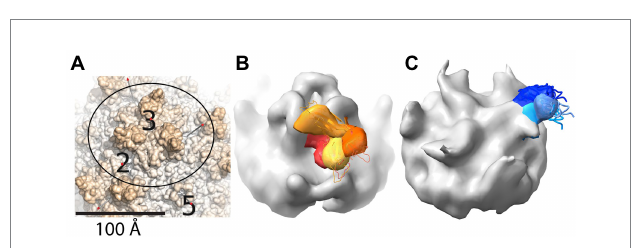
FIGURE 3 Cryo-ET reveals variable locations for neighboring PKD domains that are not strongly bound to AAV. (A) The region shown in panels (B,C) is outlined on part of the surface of the AAV2 crystal structure (PDB ID 1LP3) (Xie et al., 2002). Spikes are seen surrounding a 3-fold axis, with neighboring 2- and 5-fold axes shown for reference. (B) Cryo-ET subtomograms for an AAV2-PKD12 complex have been averaged within four classes that are superimposed with different colors (yellow through red) for the PKD1 domain that is in variable orientation. Regions in common between the classes are colored grey, and comparison with panel (A) shows the added mass of PKD2 running up from near the 2-fold to above the 3-fold spike. (C) Cryo-ET subtomogram class averages for AAV5-PKD12 that have been similarly represented to show the variable orientations of PKD2 (shades of blue) emanating from a symmetry-related 2-fold axis behind the spike. PKD1 is bound in a single configuration, adding to the grey volume ( cf. panel A ) between the 5- and 2-fold axes. Panels are taken with permission from Hu et al.